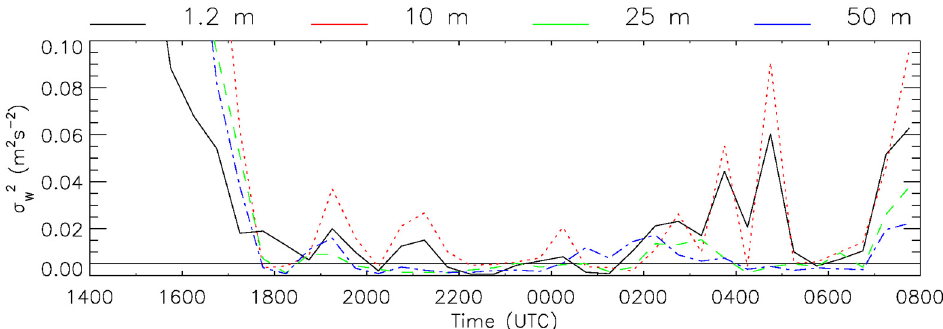
Figure 7. Vertical velocity variance for 3–4 October 2016 measured at various heights as indicated.